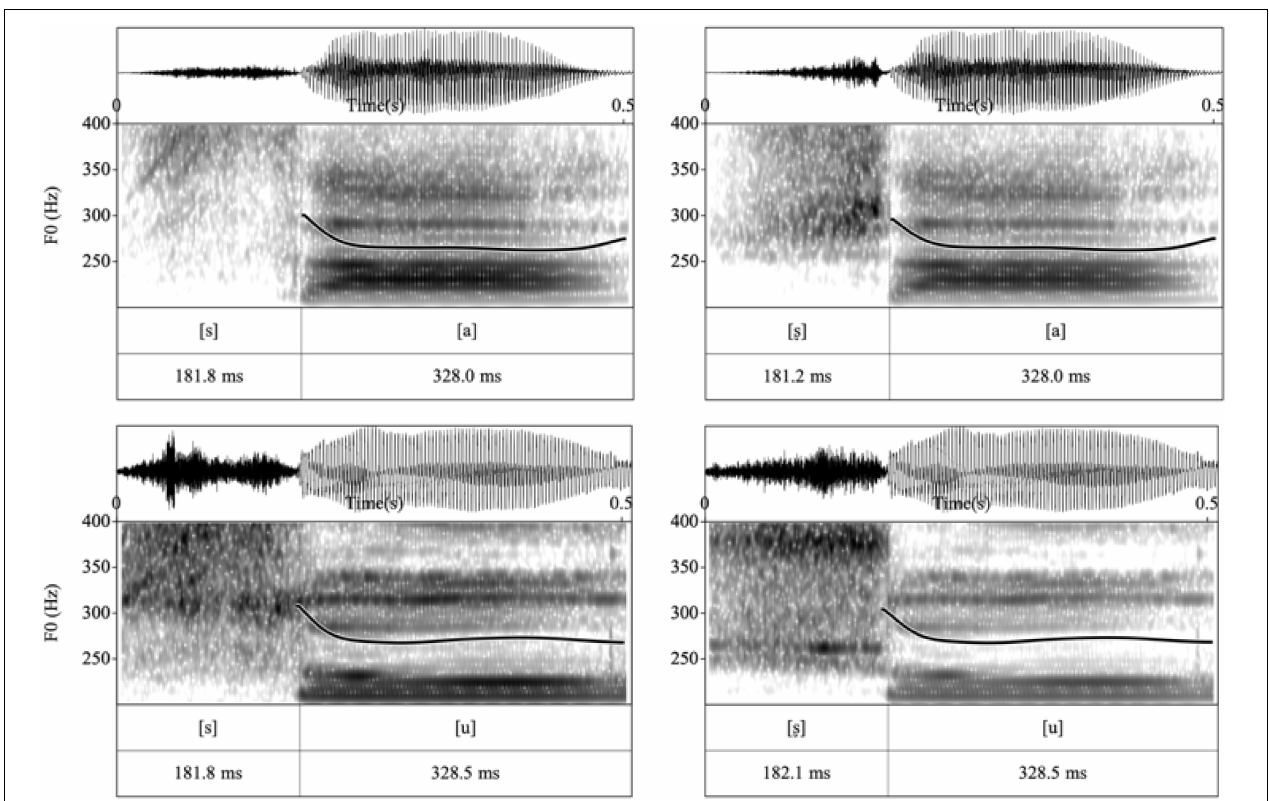
FIGURE 3 | Oscillograms (above), spectrograms (below, 0–7,000 Hz), and F0 tracks of the four stimuli. All the stimuli are Tone 1 syllables. TABLE 4 | Task design in MMN